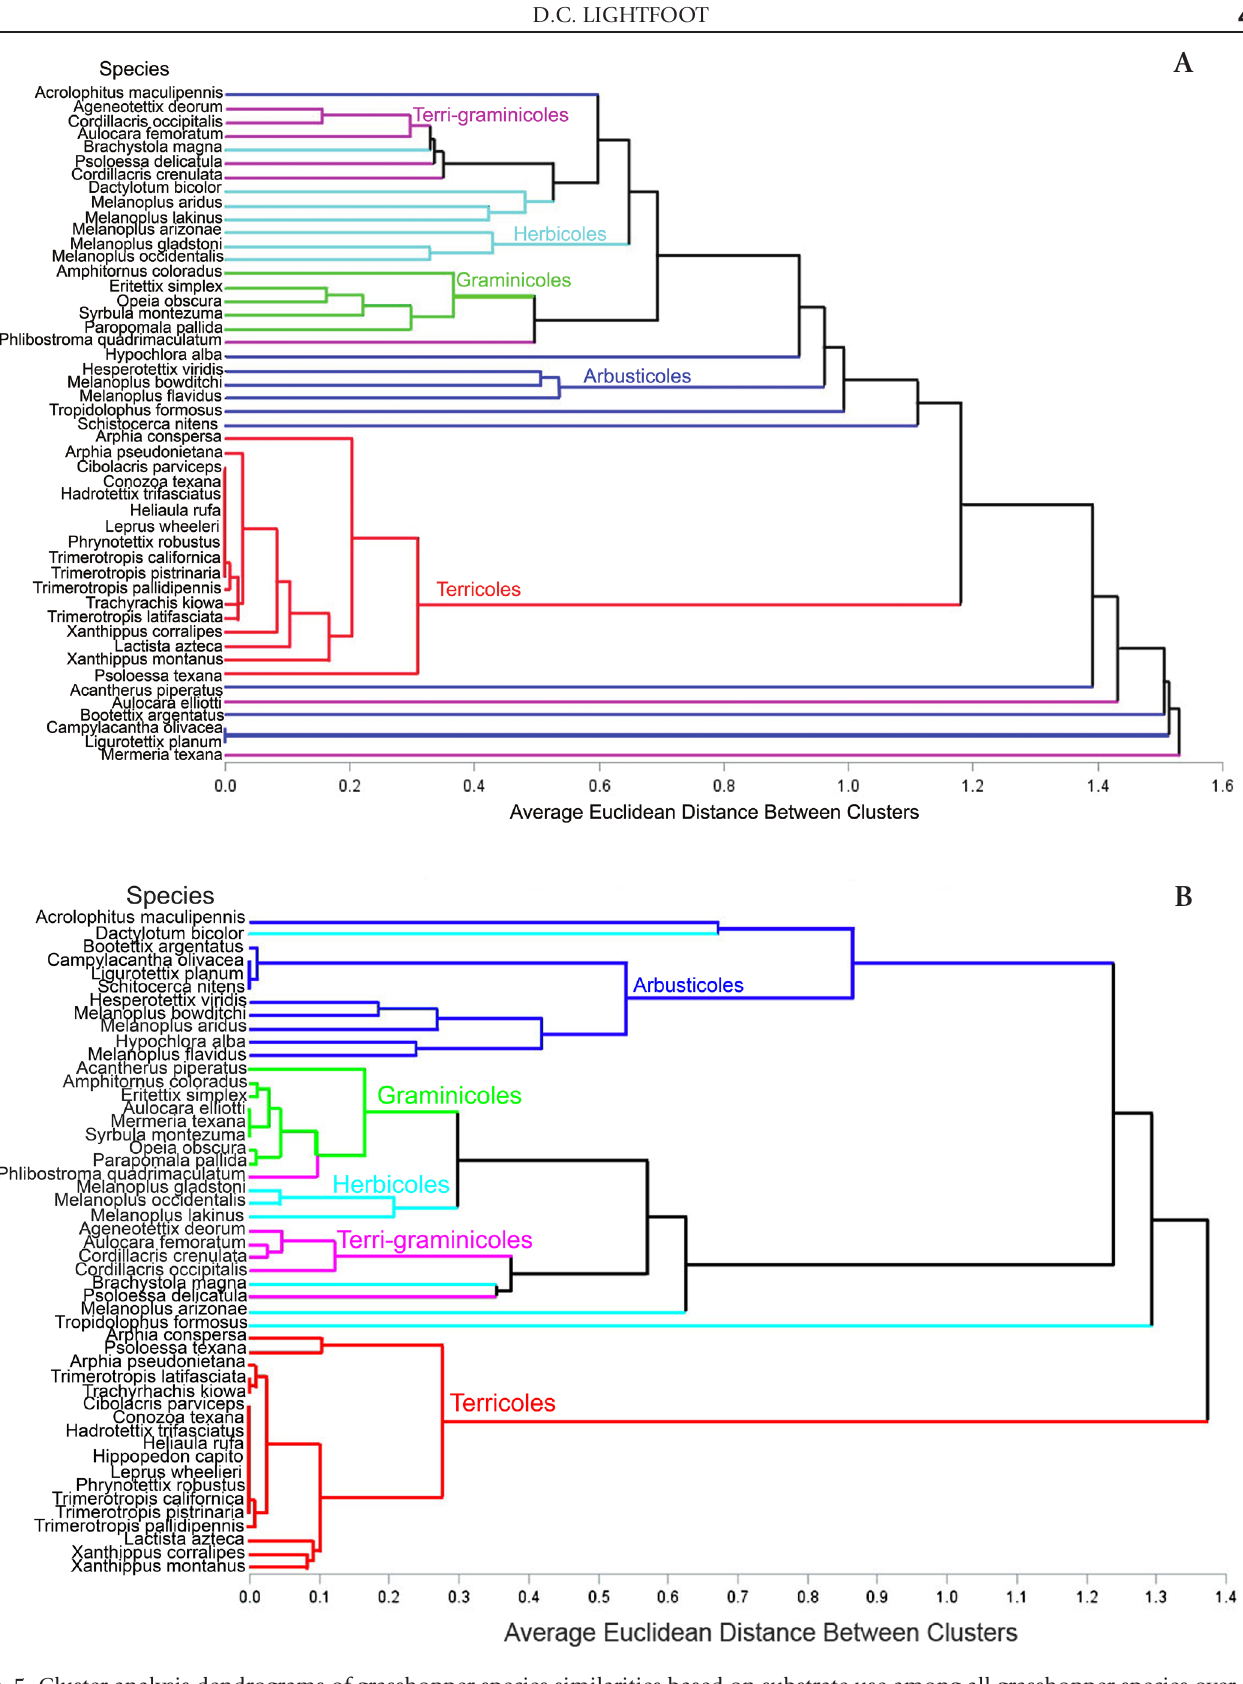
Fig. 5. Cluster analysis dendrograms of grasshopper species similarities based on substrate use among all grasshopper species over all sites, years and seasons; A. Based on specific substrate use to the plant species level and bare soil; B. Based on substrates categorized to forbs, grasses, shrubs and bare